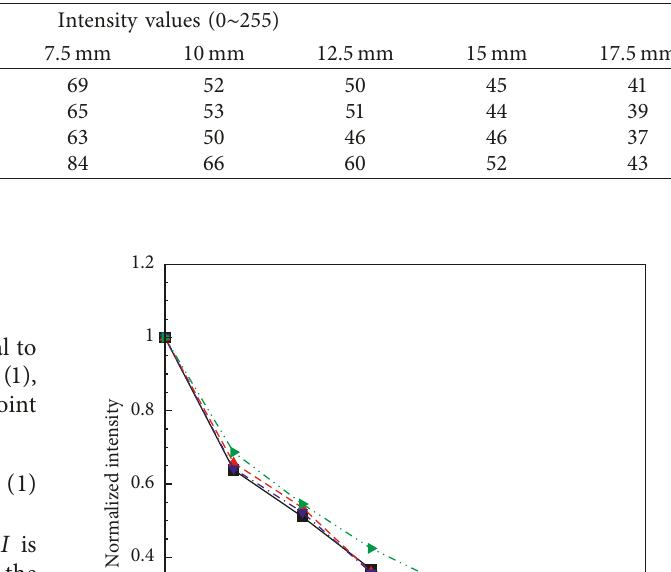
Figure 6: Intensity value of cracked area under direct lighting condition. Table 3: Intensity value of cracked area depending on illuminance under indirect lighting condition.